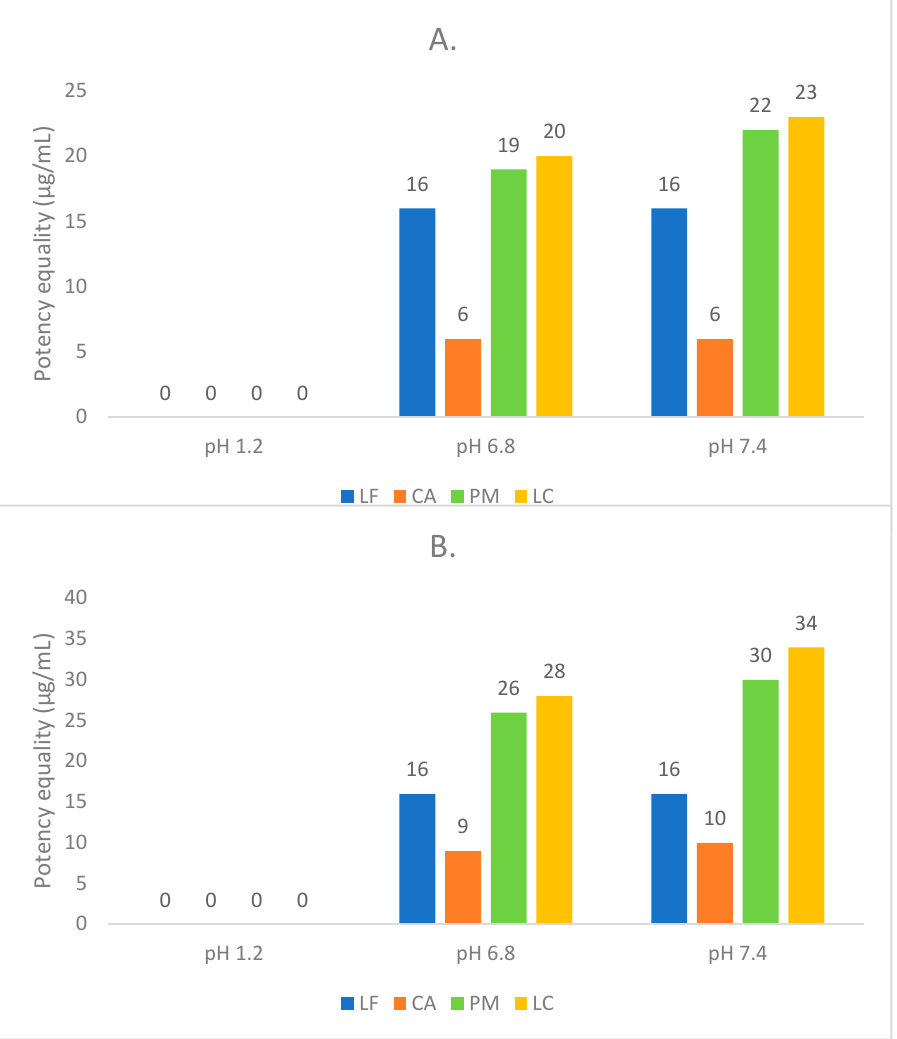
Figure 11. Antibiotic potency comparison against Staphylococcus aureus ( A ) and Escherichia coli ( B ). Note: levofloxacin (LF), citric acid (CA), levofloxacin-citrate (LC), and physical mixture (PM) of levofloxacin and citric acid.